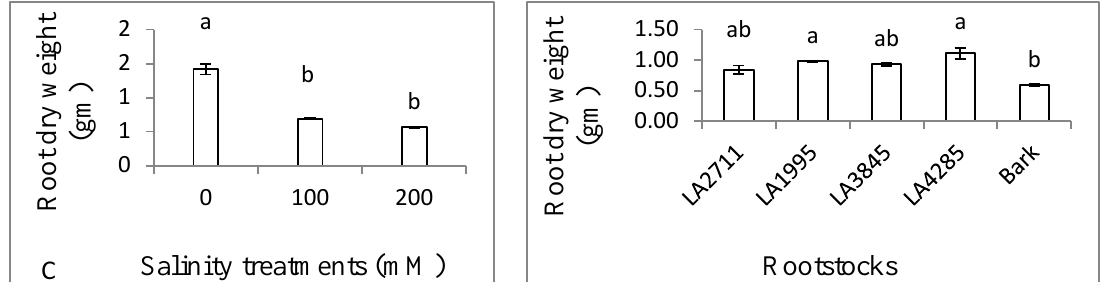
Figure 3: Effect of salt treatments and rootstocks on ( A ) root length, ( B ) root fresh weight, and ( C ) root dry weight. Different letters indicate significant differences between treatments (Tukey test at p < 0.05). Table 7. Analysis of variance (mean square) of tomato root attributes.